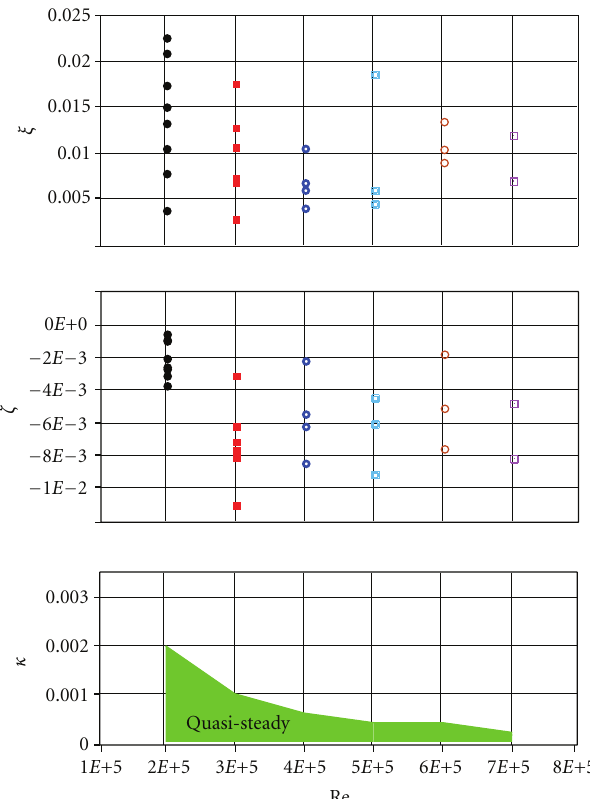
Figure 17: Summary of results obtained from quasi-steady